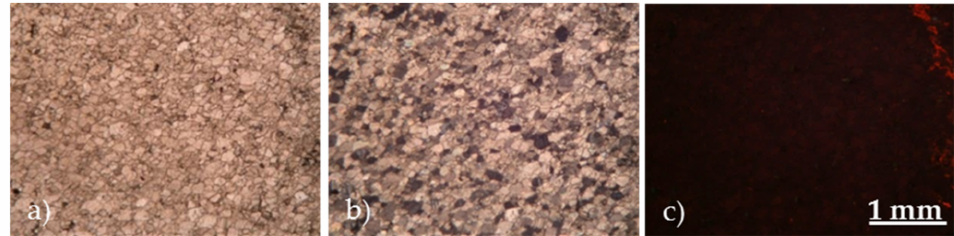
Figure 4. Photomicrographs of sample QL, all with the same scale: ( a ) in parallel polarized light; ( b ) in crossed polarized light; ( c ) CL image.